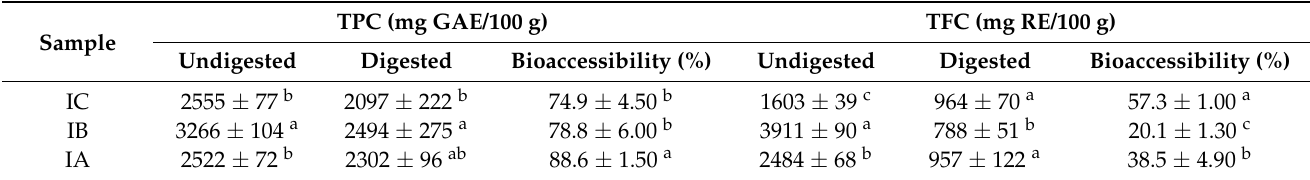
Table 1. Retention of phenolics in the formulations throughout in vitro digestion.